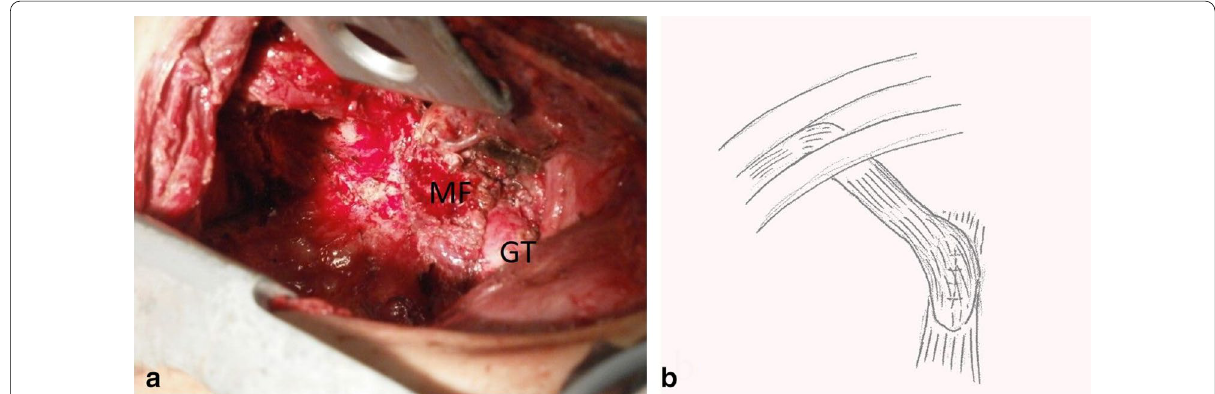
Fig. 3 Intraoperative images. a The right lower pulmonary lobe was excised, and an intercostal muscle flap was placed over the suture line of the conduit. GT gastric tube, MF muscle flap. b The schema of the surgery is shown